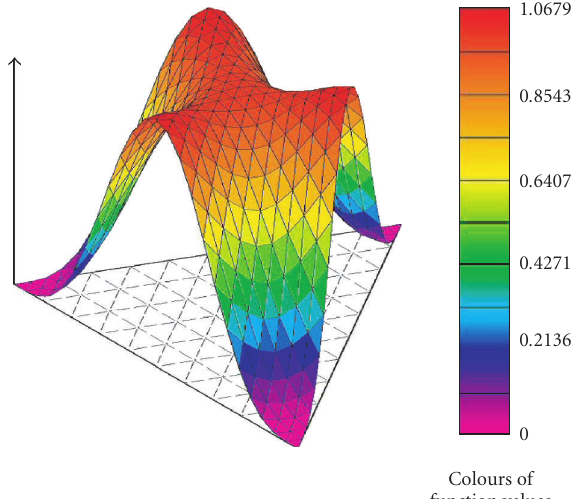
Figure 4.11. Normalised k -quadratic delta-function F 8 ( γ ) for n = 3 and k = 4 defined over triangular coordinates in the